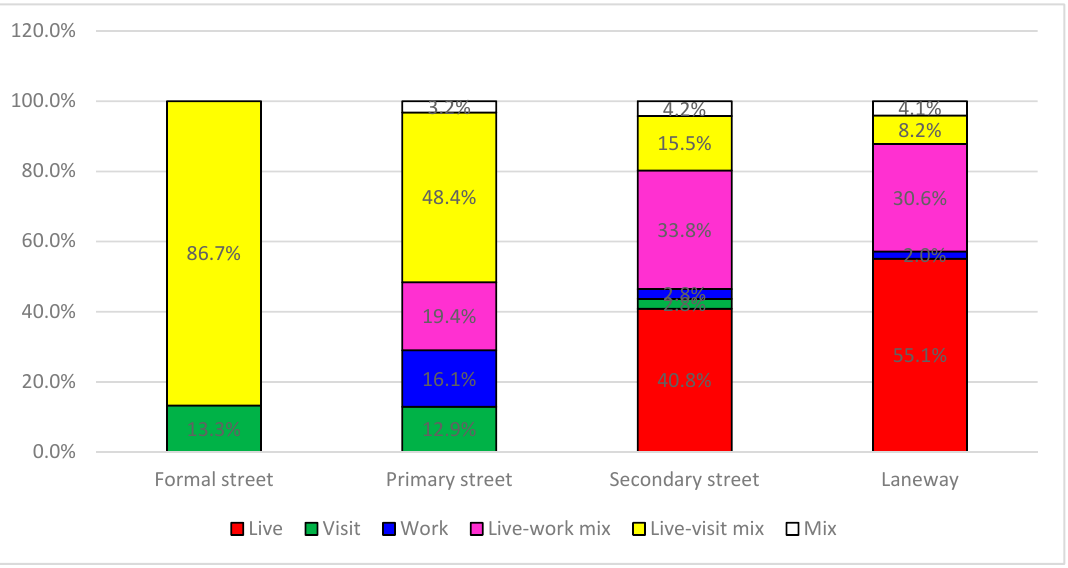
Figure 12. Functional mix of buildings.